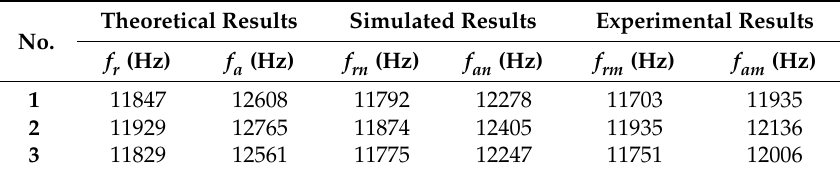
Table 2. The theoretical, simulated and experimental resonance/anti-resonance frequencies of the transducers at the fundamental mode.